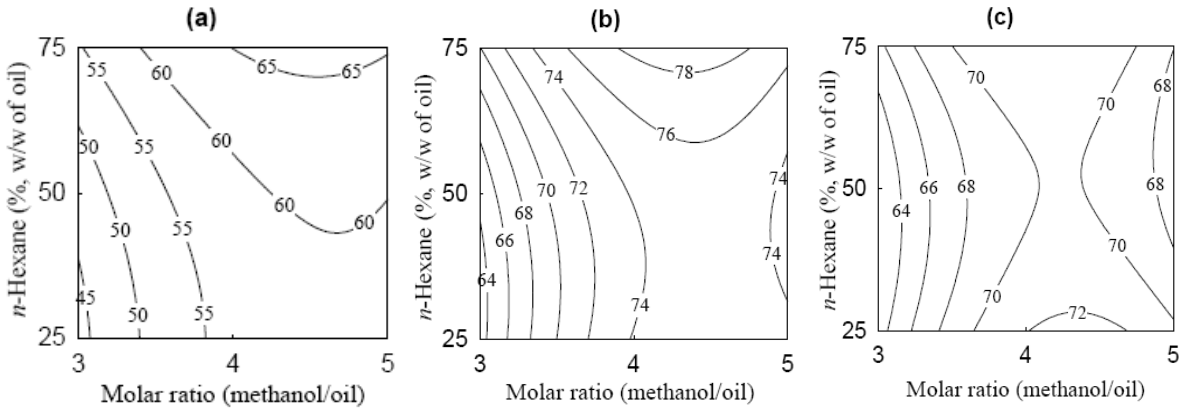
Figure 3. Contour plots of molar conversion using waste cooking oil as a feedstock